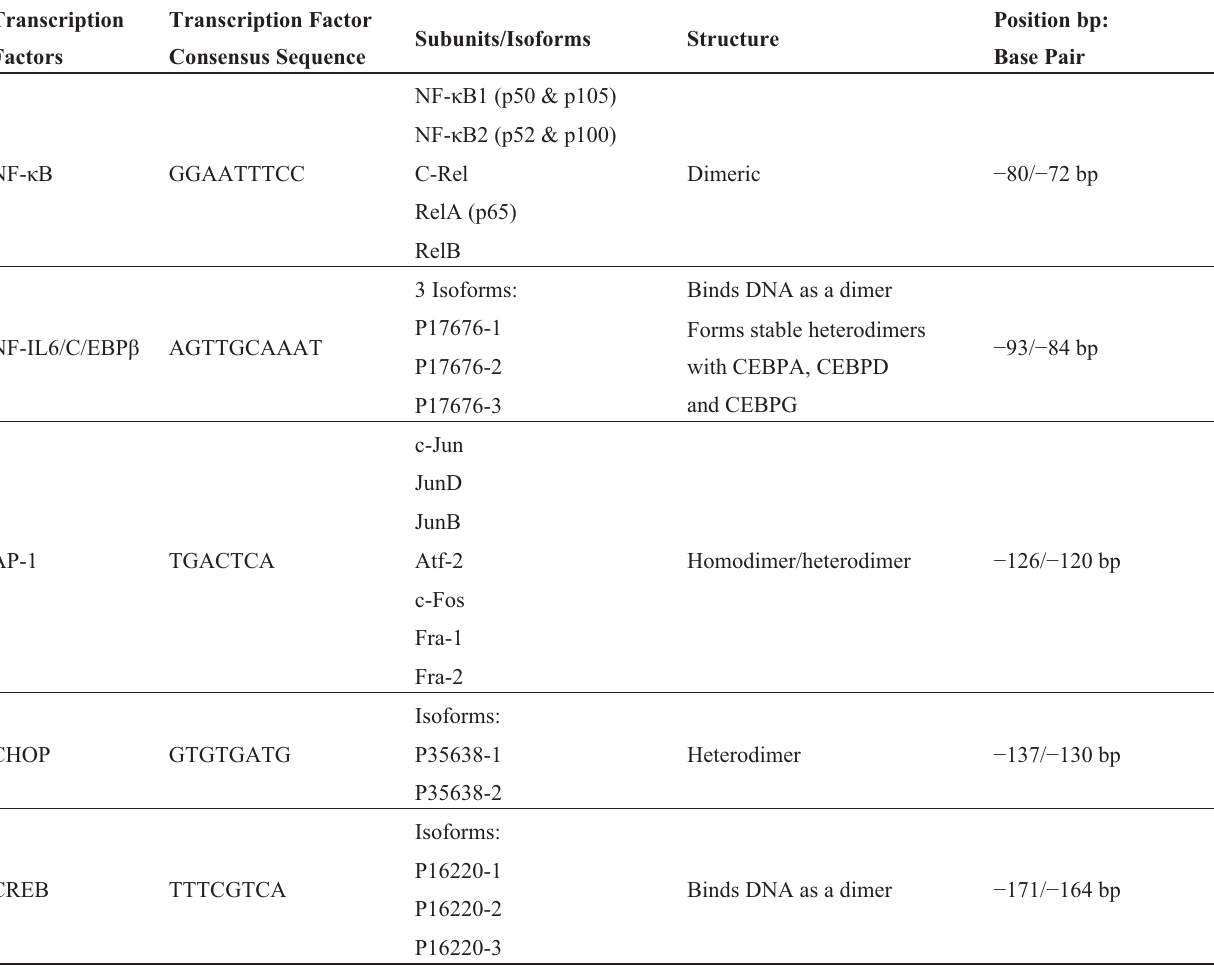
Table 1. Characteristics of transcription factors that regulate CXCL8